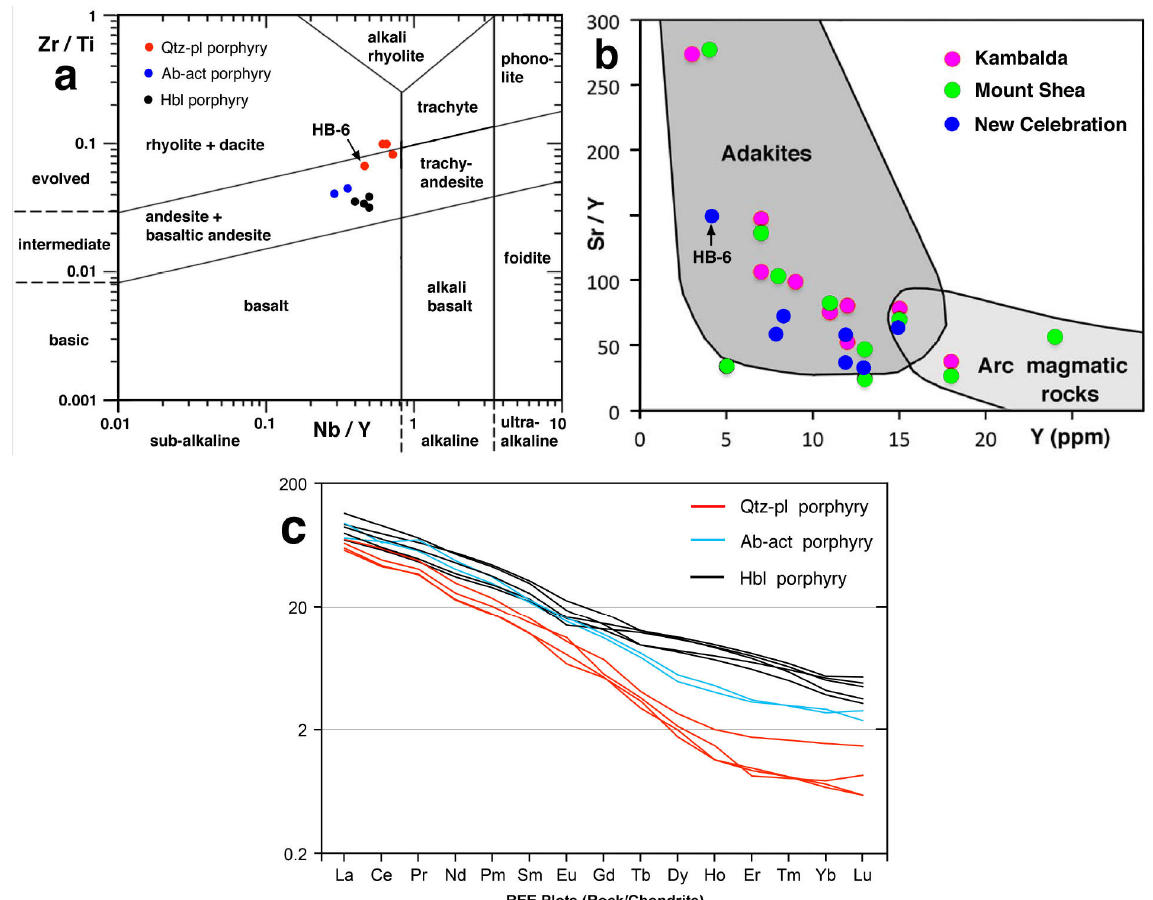
Figure 11. Classification of altered quartz-plagioclase (Qtz-pl) and albite-actinolite (Ab-act) altered porphyries from the New Celebration open pit (data in Table S1), and of hornblende (Hbl) porphyries from the wider mine area (samples 108834–108847 in [44]). ( a ) Pearce Zr/Ti versus Nb/Y diagram (after [41]) distinguishing calc–alkaline from alkaline series rocks. ( b ) Sr/Y versus yttrium adakite discrimination diagram for ca. 2660 Ma monzodiorite-suite porphyries in the Boulder Lefroy-Golden Mile fault system (modified from [5]). ( c ) Chondrite-normalized rare earth element (REE) diagram using the chondrite values in [45].